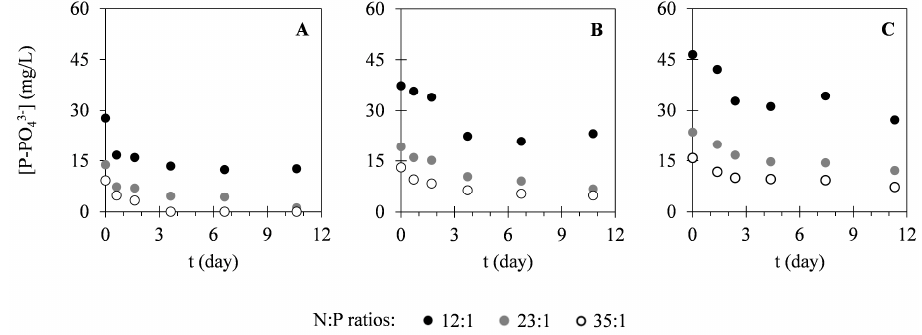
Figure 3. Temporal variation of P–PO 43 − concentrations determined in assays I ( A ), II ( B ) and III ( C ) under different N:P ratios. The presented data correspond to the mean obtained from two independent experiments.